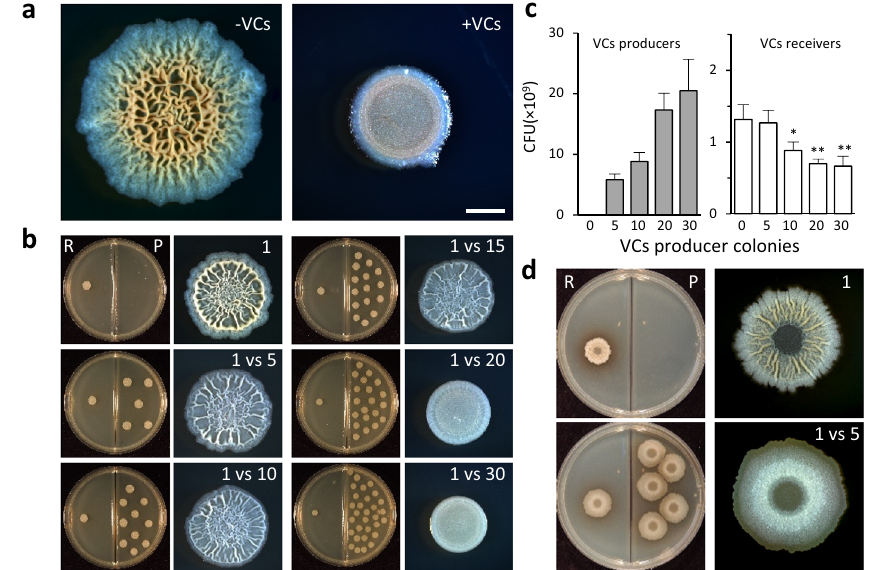
Fig. 1 VCs produced by B. subtilis bio fi lms inhibit bio fi lm development in a dose-dependent manner. a Top-down images of B. subtilis 3610 bio fi lm colonies, grown on solid B4 medium, either alone ( − VCs) or in the presence of volatile compounds produced by 80 neighbouring colonies ( + VCs). Colonies were incubated for 4 days at 30 °C. Scale bar 2 mm. Images are representative of ( n > 3) independent experiments. b B. subtilis 3610 bio fi lm colonies (R — receiver) grown in divided Petri dishes on solid B4 medium in the presence of an indicated number of neighbouring colonies (P — producer). Left — experimental setting, right — a close-up of the receiving colony. Colonies were incubated for 2 days at 30 °C. Images are representative of ( n > 3) independent experiments. c Colony-forming units were determined for VCs producer (left) and receiver (right). Colonies ( n = 6) were grown as in b . P -values, as determined by ANOVA followed by Tukey HSD are indicated (* p Val < 0.01, ** p Val < 0.001 vs 0 VCs producers). d B. subtilis 3610 bio fi lm colonies (R — receiver) grown on solid MSgg medium in the presence of 5 neighbouring colonies (P — producer). Left — experimental setting, right — a close-up of the receiving colony. Colonies were incubated for 2 days at 30 °C. Images are representative of ( n > 3) independent